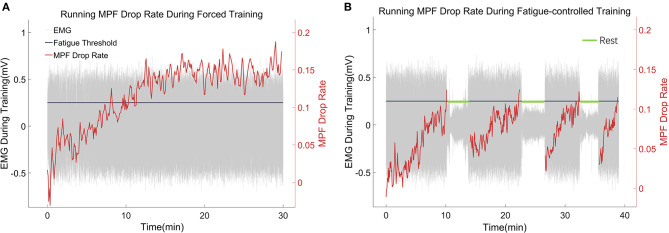
(A,B) Representative trials of the MPF drop rate during treadmill training in the FOR-T group and FAT-C groups. The red lines were real-time MPF drop rates. The gray parts were EMG thumbnails, and the amplitude around ±0.5 mV stood for scuttle, while the amplitude around 0 mV represented the 3 min rest. The black line was the MPF threshold for the FAT-C group.